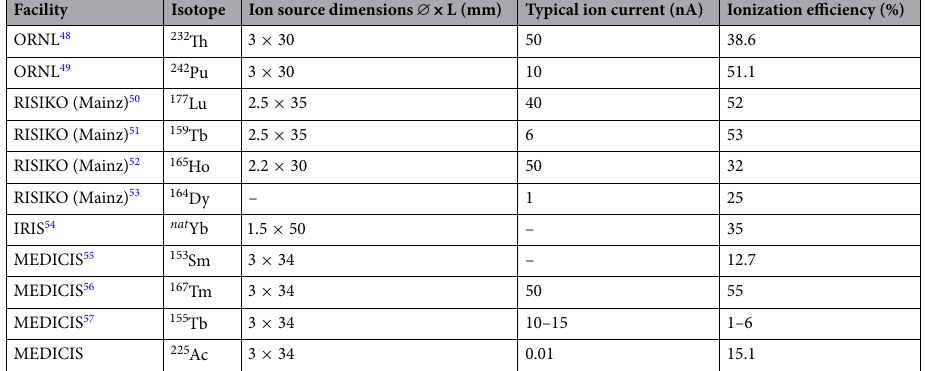
Table 1. Ionization efficiencies and maximum post-magnetic-separation ion currents for some previously studied actinides and